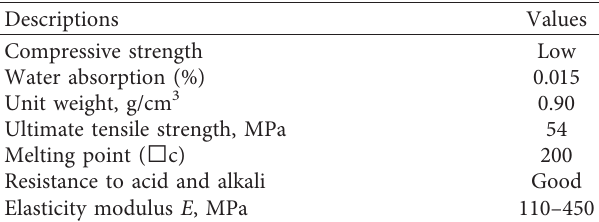
Table 2: Description of the plastic waste strips